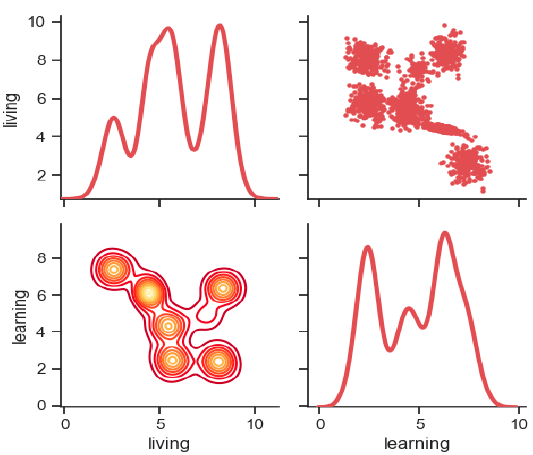
Figure 4. The scatter plot matrix of S1.